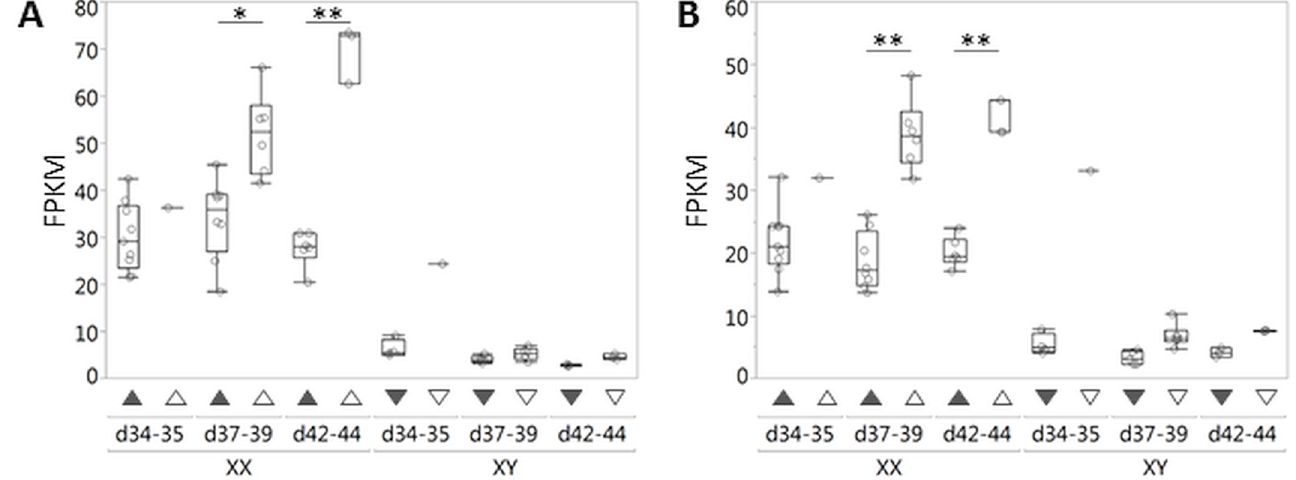
Fig 4. RSPO1 and WNT4 expressionin canine embryonic gonads was measuredby RNA-seq. (A) RSP01 and (B) WNT4 expressionwere lower in XX DSD gonadsat risk (filled triangles) compared to those of XX age-matched controls (open triangles)at d37-39and d42-44. Neither RSP01 nor WNT4 expressionin XX DSD gonads at risk or those of XX age-matched controls was as low as those of XY littermate controls (filled invertedtriangles)or XY age-matched controls (open invertedtriangles). Each open circle represents RNA from one embryonic gonad pair, except for d34, which represents RNA from a gonad pool. Differential expressionwas statistically tested for XX DSD gonadscomparedto XX controls at d37-39 and d42-44( * p-value < 0.005; ** p-value (cid:20) 0.00005). FPKM is Fragments Per Kilobase of transcript per Millionmapped reads.